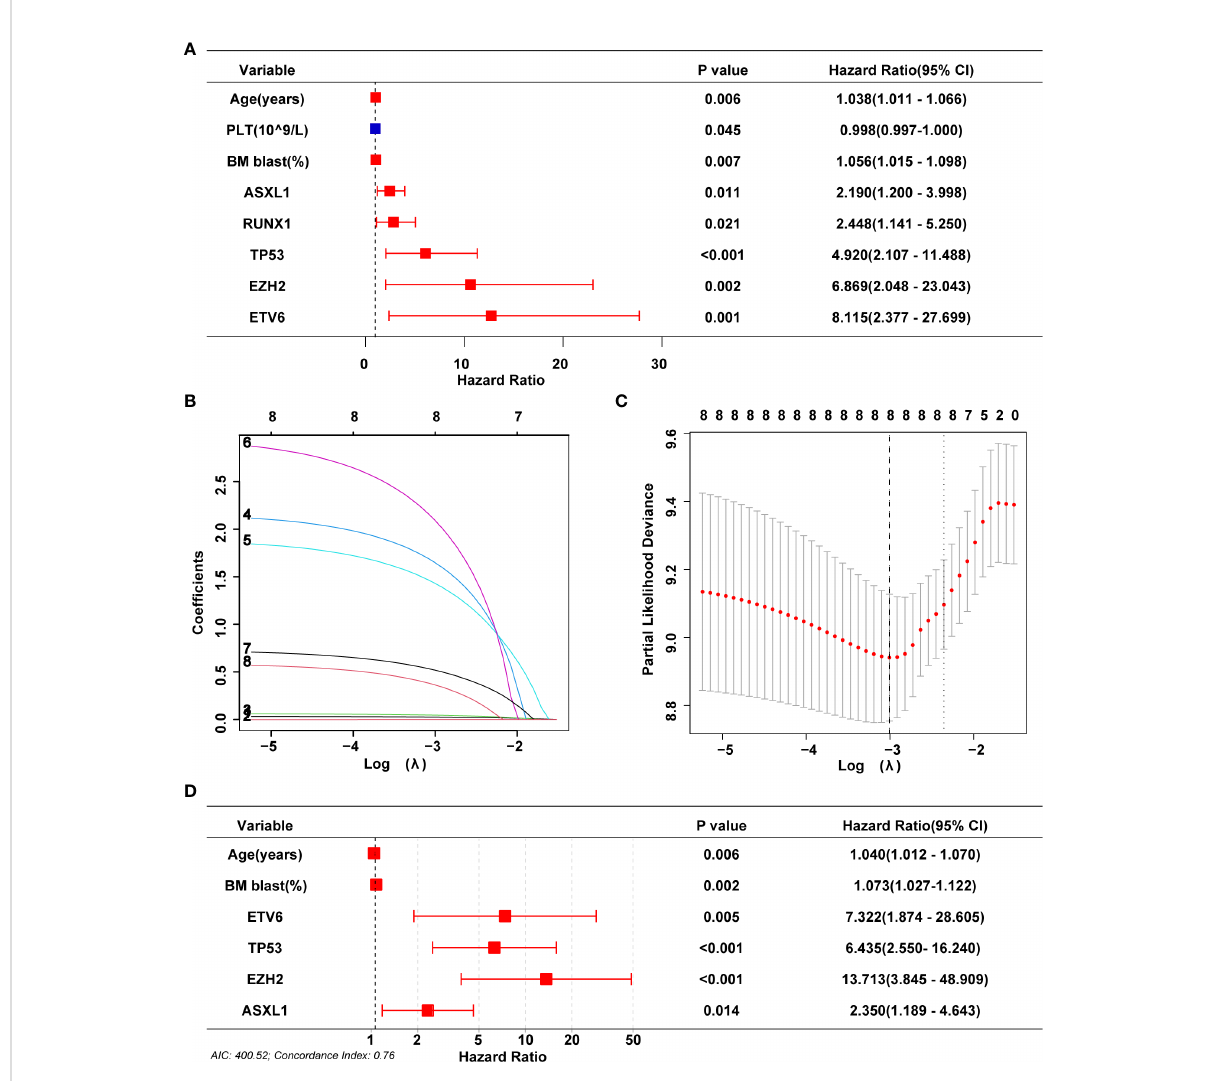
FIGURE 4 Screening for prognosis-related variables. (A) Univariate Cox analyses on variables for the prediction of overall survival of MDS patients in training cohort. Graph only shows signi fi cant results (P<0.05). (B, C) LASSO-Cox regression by 10-fold cross-validation was performed to select key variables. (D) Multivariate Cox proportional hazards were used for identifying independent prognostic